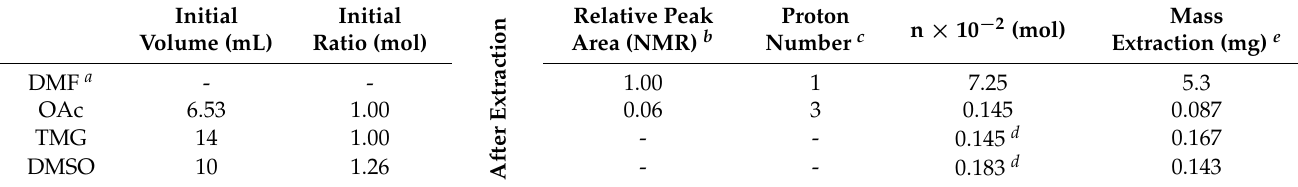
Table 6. Quantification of [TMG][OAc] extraction by 1 H-NMR spectrum analysis.